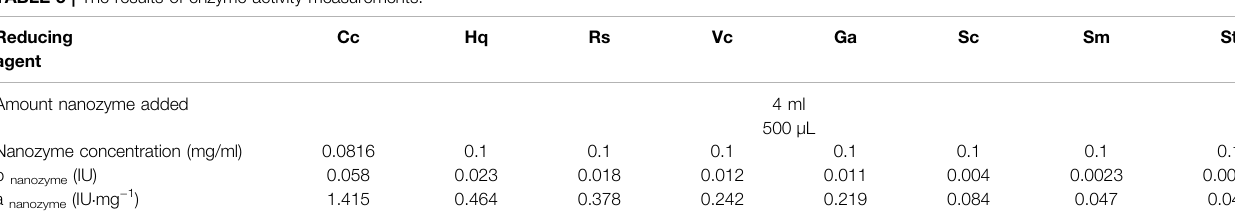
TABLE 5 | The results of enzyme activity